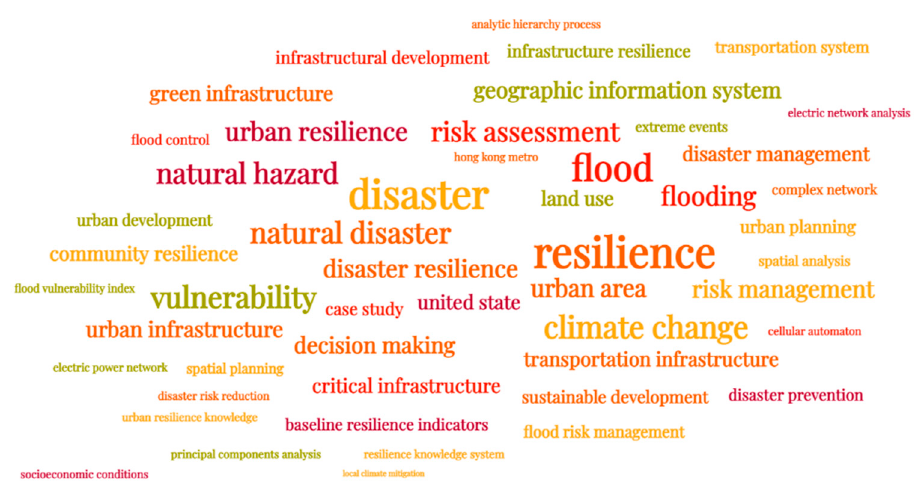
Figure 3. Word cloud of 67 chosen articles.